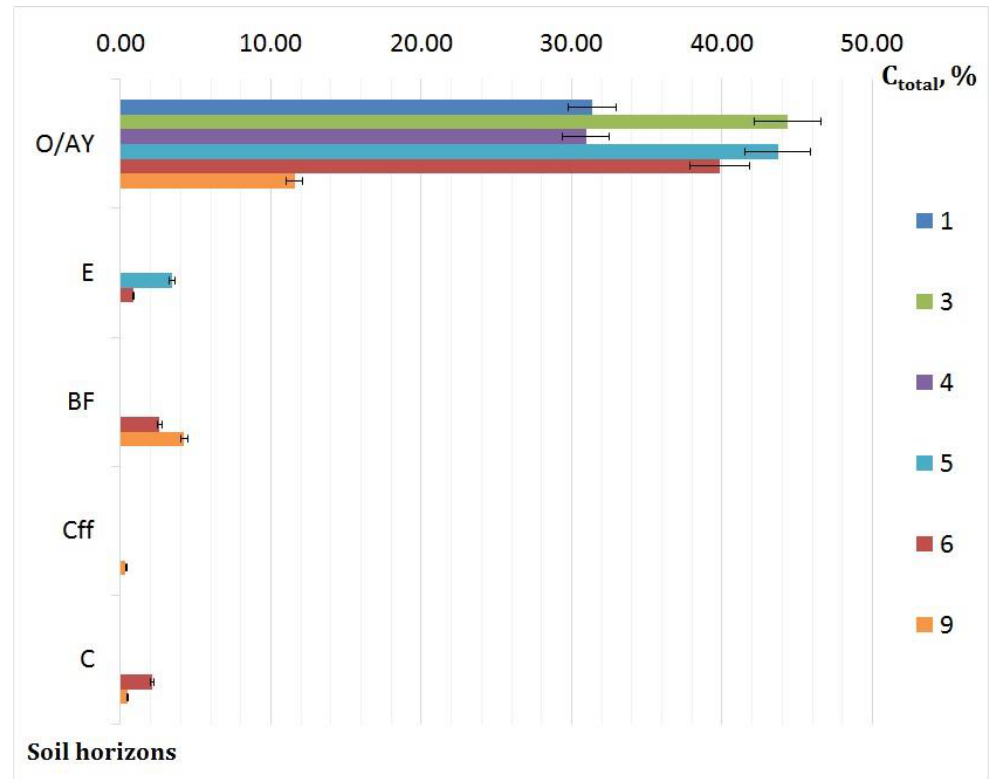
Figure 8. C total content (%) in fallow soils on Gogland (No. of soil pits, according to Figure 7).